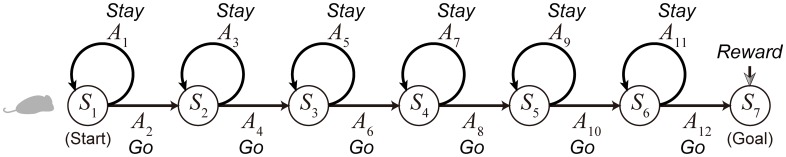
Modeling the behavior of subject performing a task that requires self-paced voluntary approach (whether spatially or not) towards a goal.We posited that self-paced voluntary approach can be represented as a series of ‘Go’ or ‘Stay’ selections, as illustrated here. Subject starts from S1, and chooses ‘Go’ or ‘Stay’ according to their learned values in a soft-max manner in each state until reaching the goal (S7), where reward is obtained. The values of actions (‘Go’ and ‘Stay’) are learned through temporal-difference (TD) reinforcement learning (RL) incorporating the decay of learned values (referred to as the ‘value-decay’): learned value of arbitrary action (‘Go’ or ‘Stay’) is multiplied, at every time step, by (1 –φ), where φ (0 ≤ φ ≤ 1) represents the decay rate: φ = 0 corresponds to the case without value-decay.